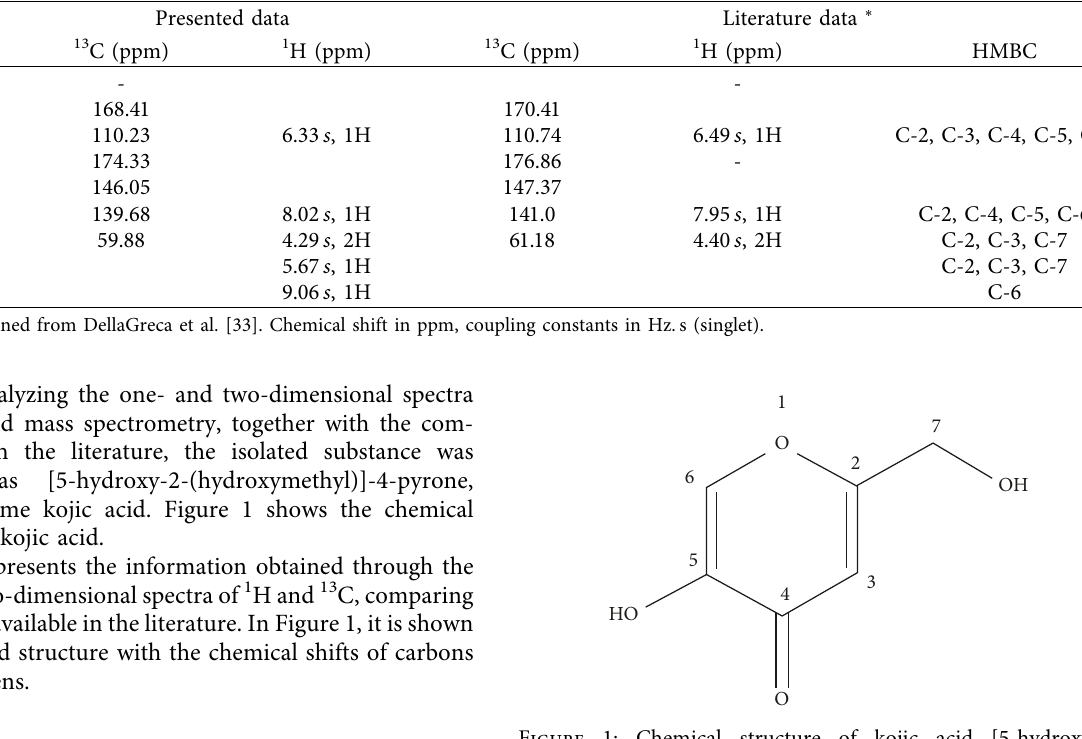
Figure 1: Chemical structure of kojic acid [5-hydroxy-2-